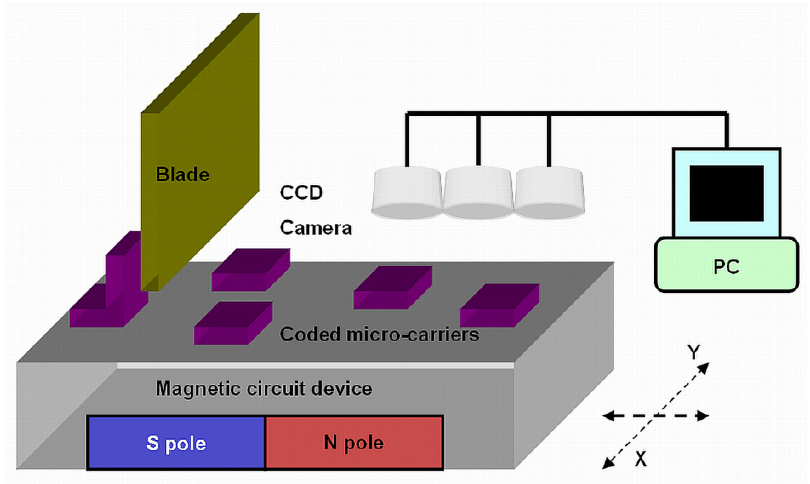
Figure 4. Schematic illustration of the testing